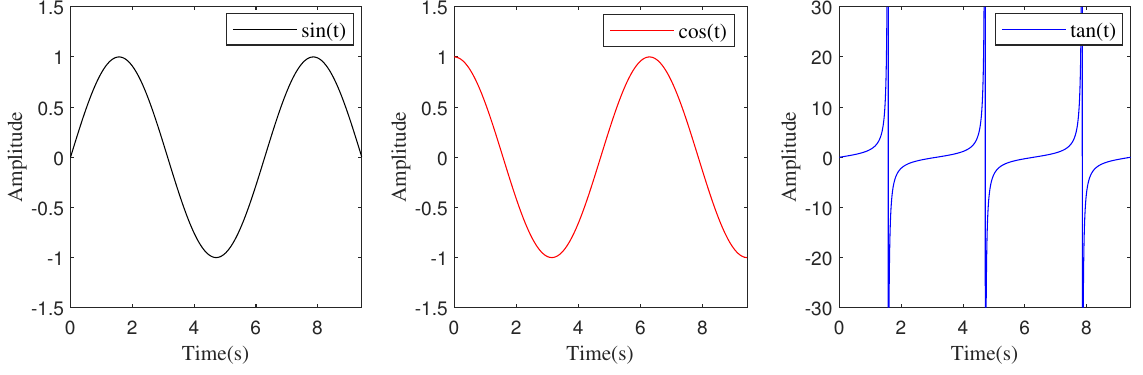
Figure 3. Different trigonometric functions plot in the range of [ 0,3 π ]